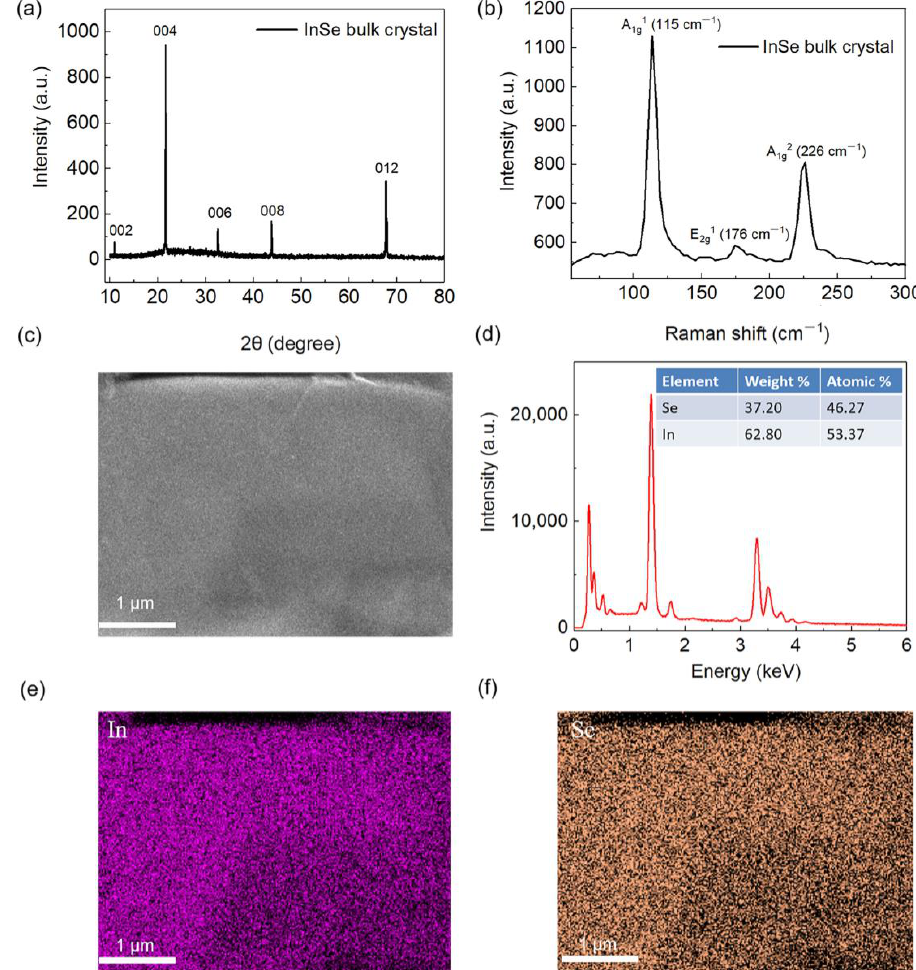
Figure 1. ( a ) XRD spectrum of InSe bulk crystal. ( b ) Raman spectrum of InSe bulk crystal. ( c ) SEM image of InSe bulk crystal. ( d ) EDX of InSe bulk crystal. ( e , f ) Elemental mapping image of InSe bulk crystal.